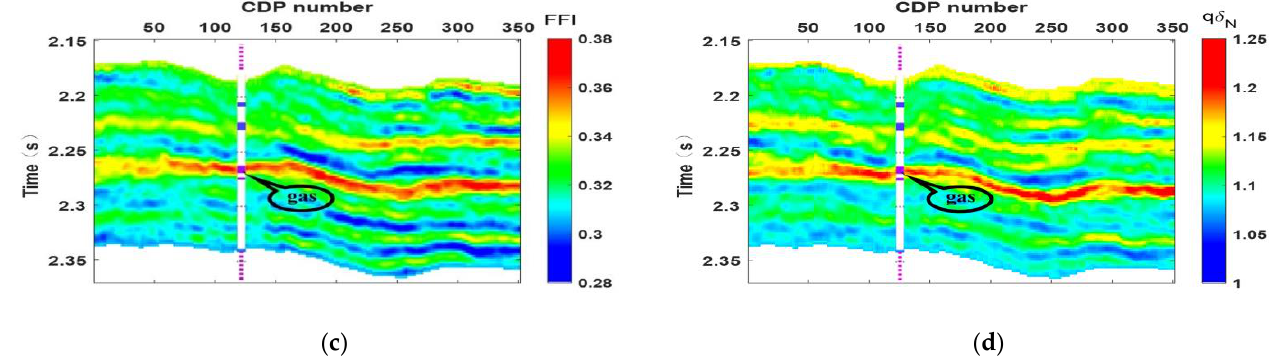
Figure 9. Estimated model parameters from inverted azimuthal EI data: ( a ) P-wave impedance, ( b ) P- to S-wave impedance ratio, ( c ) FFI , and ( d ) quasi-normal fracture weakness.